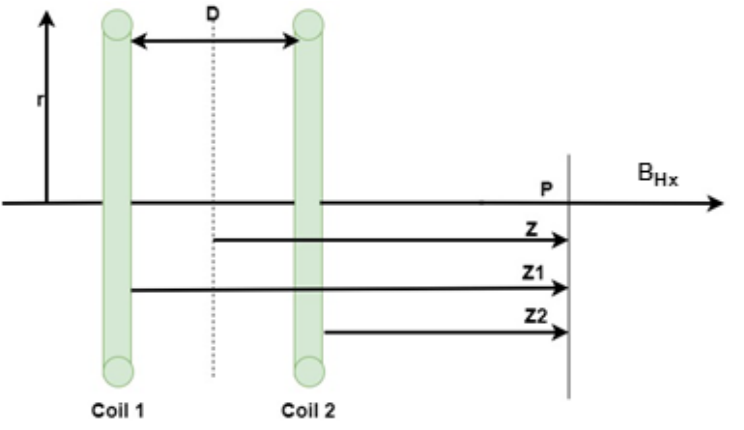
Figure 1. Magnetic field produced from two identical circular coils.